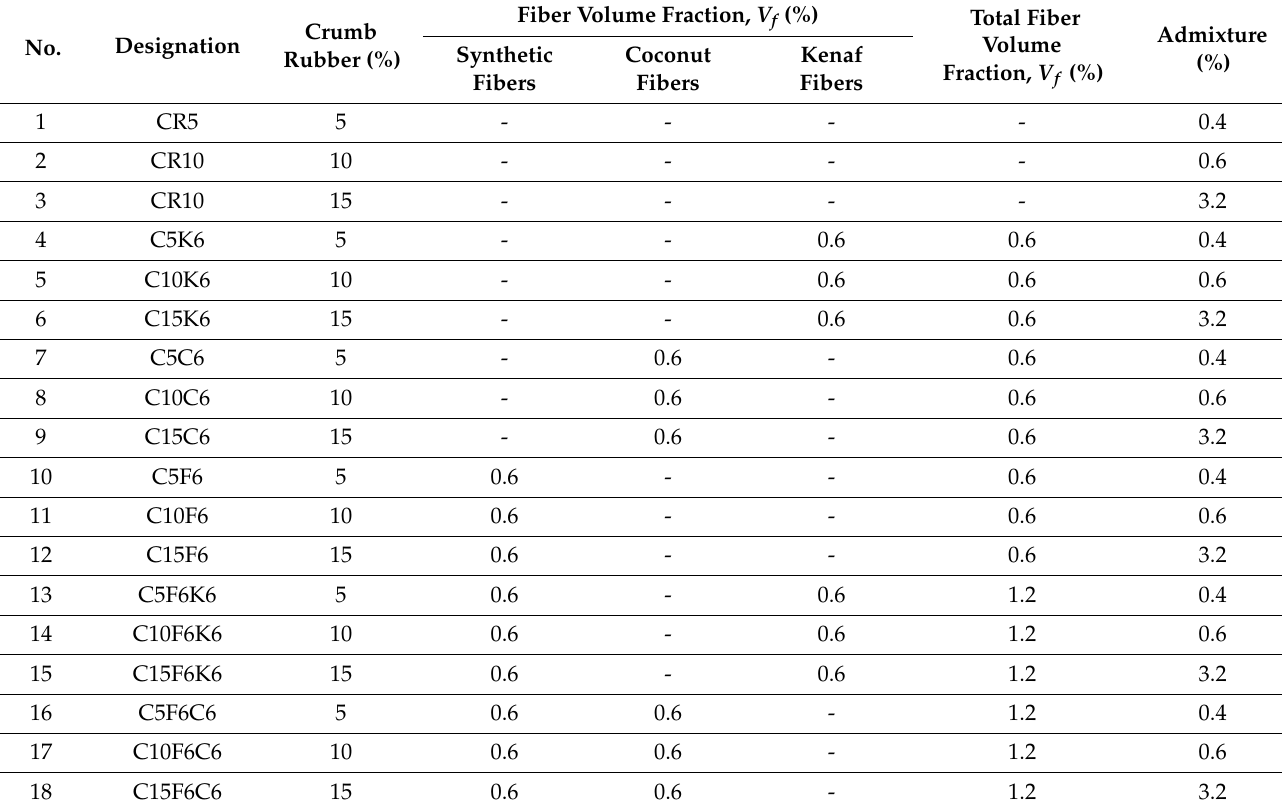
Table 1. Admixture and fiber